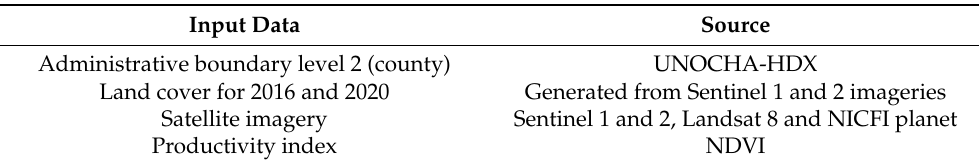
Table 3. Input data for measuring degraded land (SDG 15.3.1) and delineating parcels for hedgerow and tree plantations.